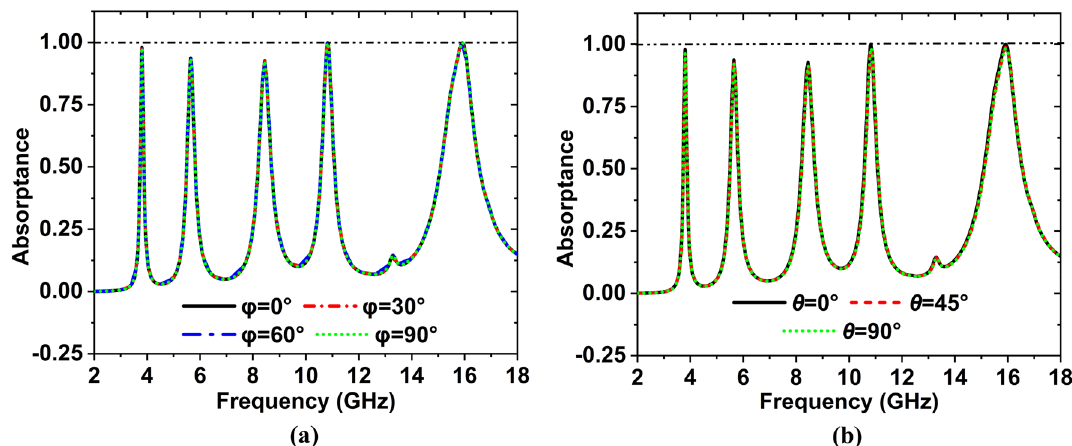
Figure 5. For various polarized EM waves absorptance in TEM mode ( a ) normal incidence ( b ) oblique